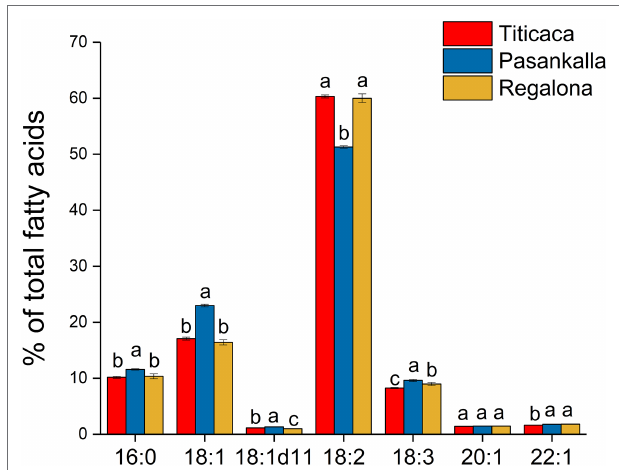
FIGURE 5 | Fatty acid profile (mol % of total fatty acids) of triacylglycerol (oil) in mature quinoa seeds of Titicaca, Pasankalla, and Regalona. Results are showing mean values ± SD of three biological replicates. Bars that do not share a letter (for each individual fatty acid) are significantly different according to Tukey’s test ( p ≤ 0.05).